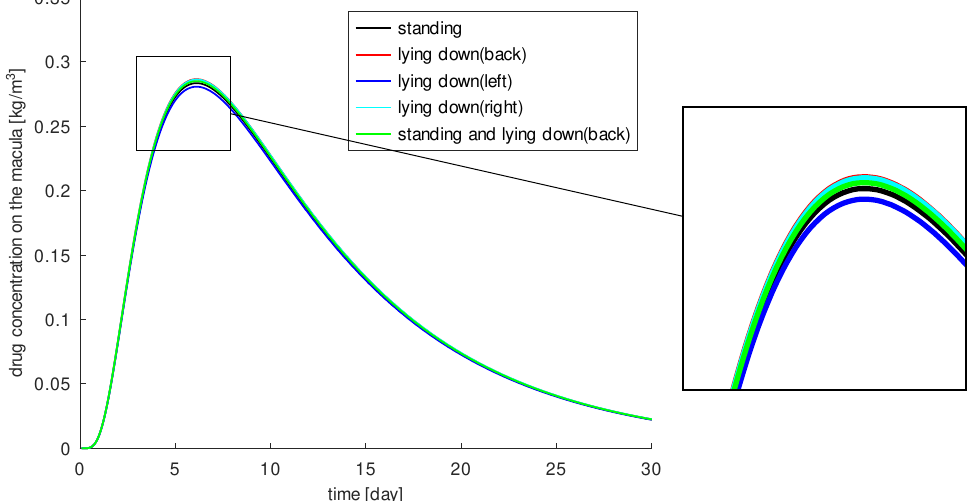
Figure 3. The drug amount around the macula for different head positions: standing (black), lying down on the back (red), lying down on the left side (blue), lying down on the right side (light blue), and standing half the day and lying down on the back the other half of the day